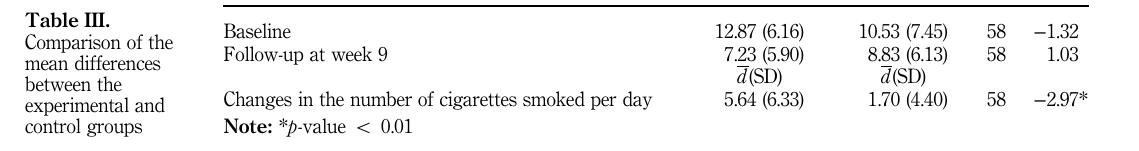
Table III. Comparison of the mean differences between the experimental and control groups